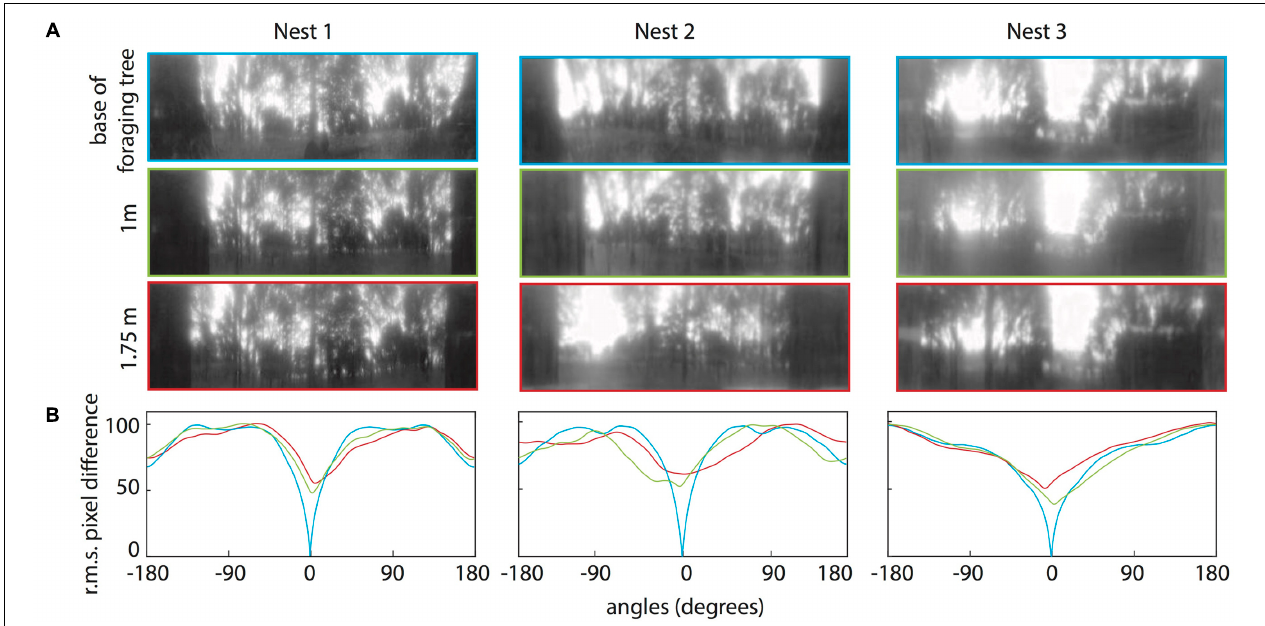
FIGURE 6 | Quantifying the change in the panorama at different elevations on the foraging tree at the three nests. (A) Panoramic images at the base of the foraging tree (blue), 1 m in height (green), and 1.75 m in height (red). Images were downscaled to 1 pixel per 1 ◦ to resemble the ant’s visual acuity, filtered through only the blue colour channel and oriented with the nest centred. (B) The rotIDF compares the root mean square pixel difference between the panorama at the base of the foraging tree with itself (blue), the 1 m (green), and the 1.75 m (red) panoramas. The nest direction in all comparisons is centred at 0 ◦